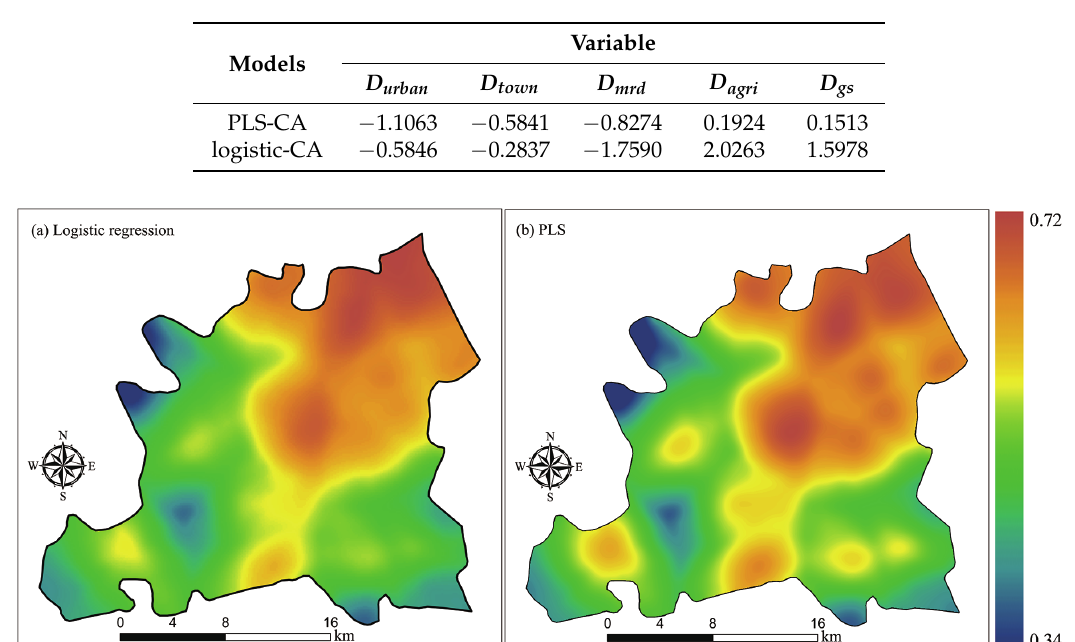
Table 4. Comparison of CA parameters generated by PLS and logistic regression.